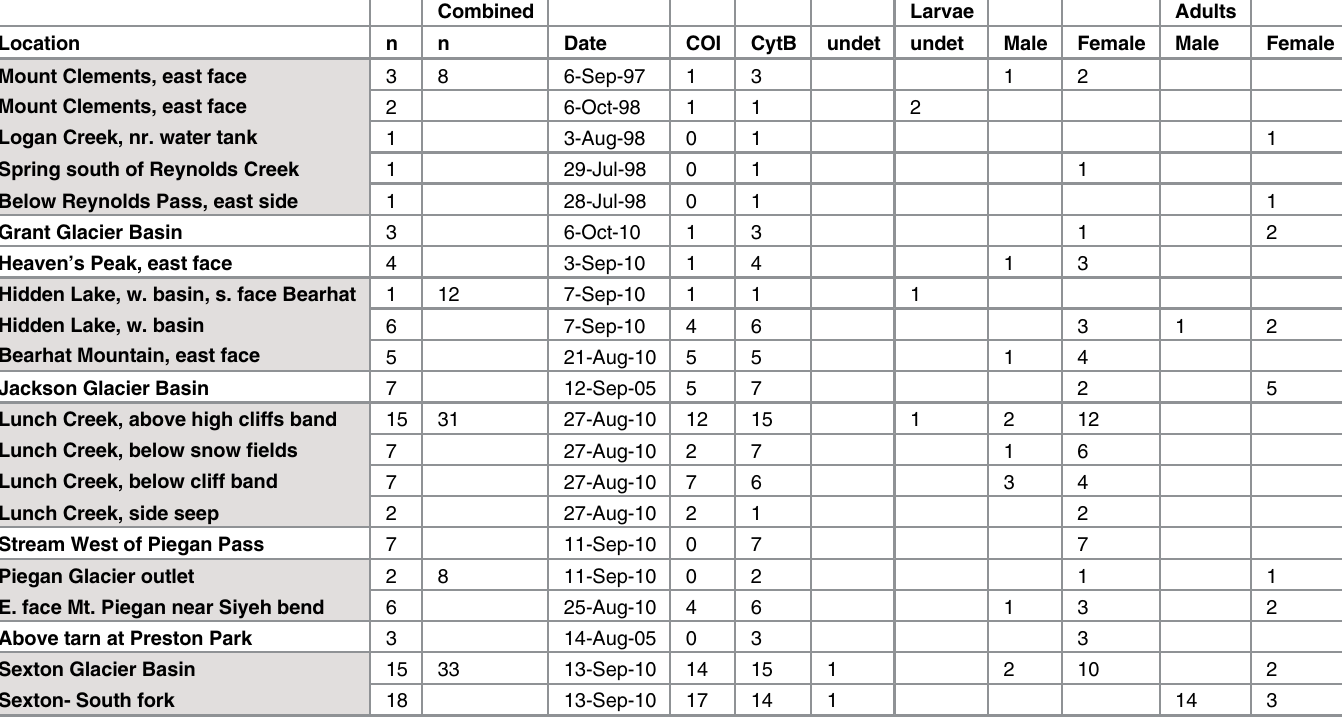
Table 1. Sampling and demographic information for 116 Lednia tumana individuals. Shaded boxes indicate adjacent sites that were pooled for com- bined analysis, and the Combined n refers to the combined totals of those